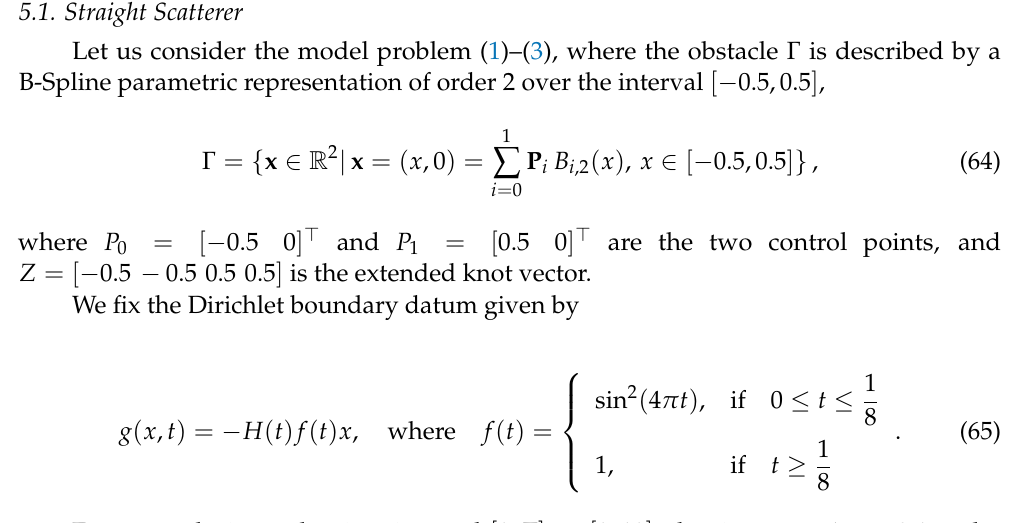
Figure 1. Approximated density ˜ ψ (